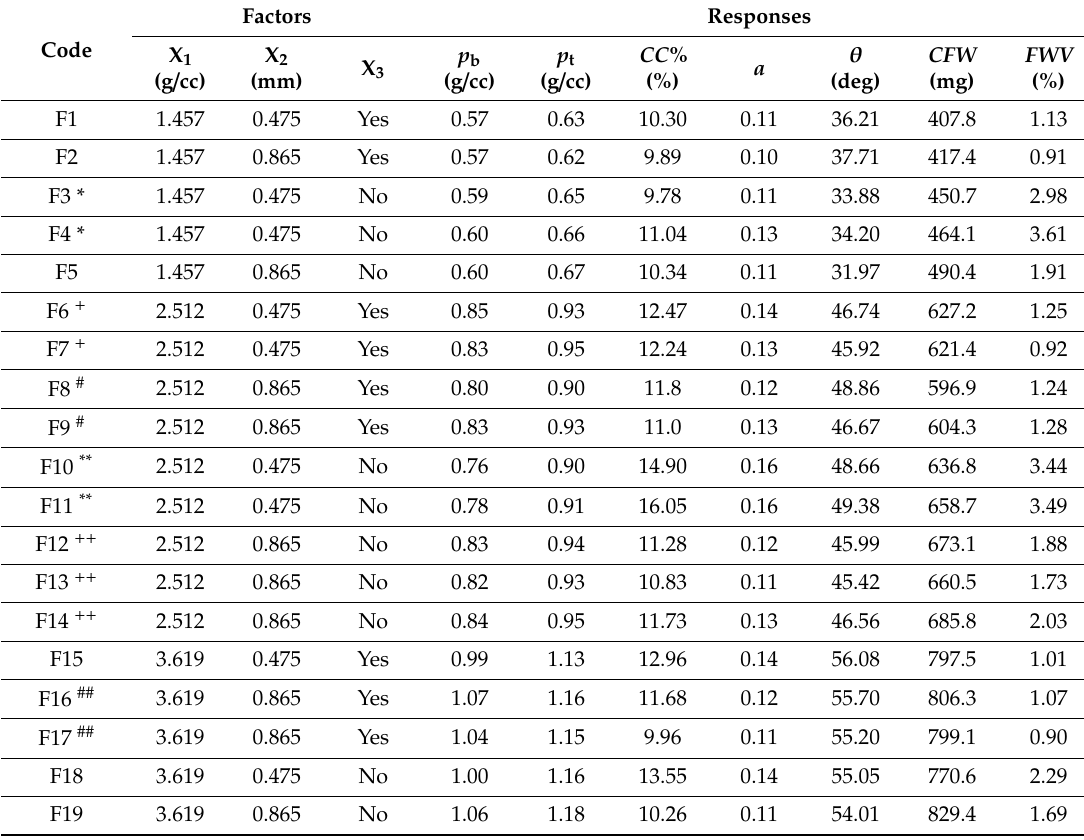
Table 3. Results of the tapping experiments and capsule filling of pellets according to the experimental design.